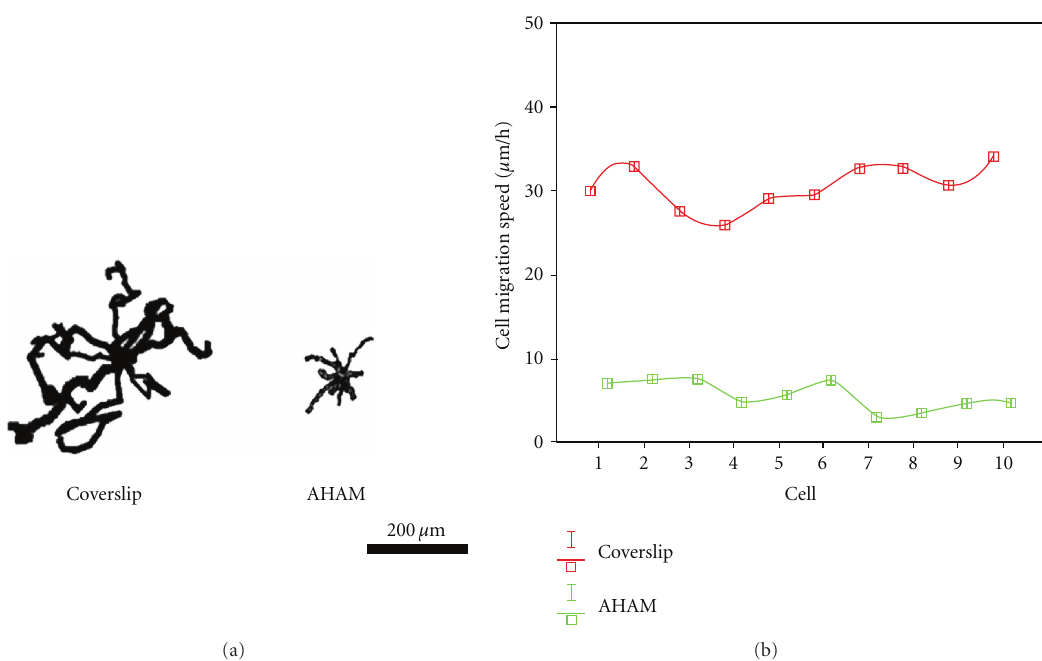
Figure 6: HFF migration patterns at 8 h after seeding. Images were obtained every 15min over a 6h period. (a) Ten representative paths of cells on coverslips or the AHAM were positioned with a common origin to generate a star-like pattern. Faster migration produced larger star patterns. On the AHAM, HFFs moved with more monoleading processes in an almost straight line, whereas HFFs on coverslips moved randomly. (b) Chart showing that the speed was significantly di ff erent between cells cultured on the AHAM and coverslips. Scale bar, 200 μ